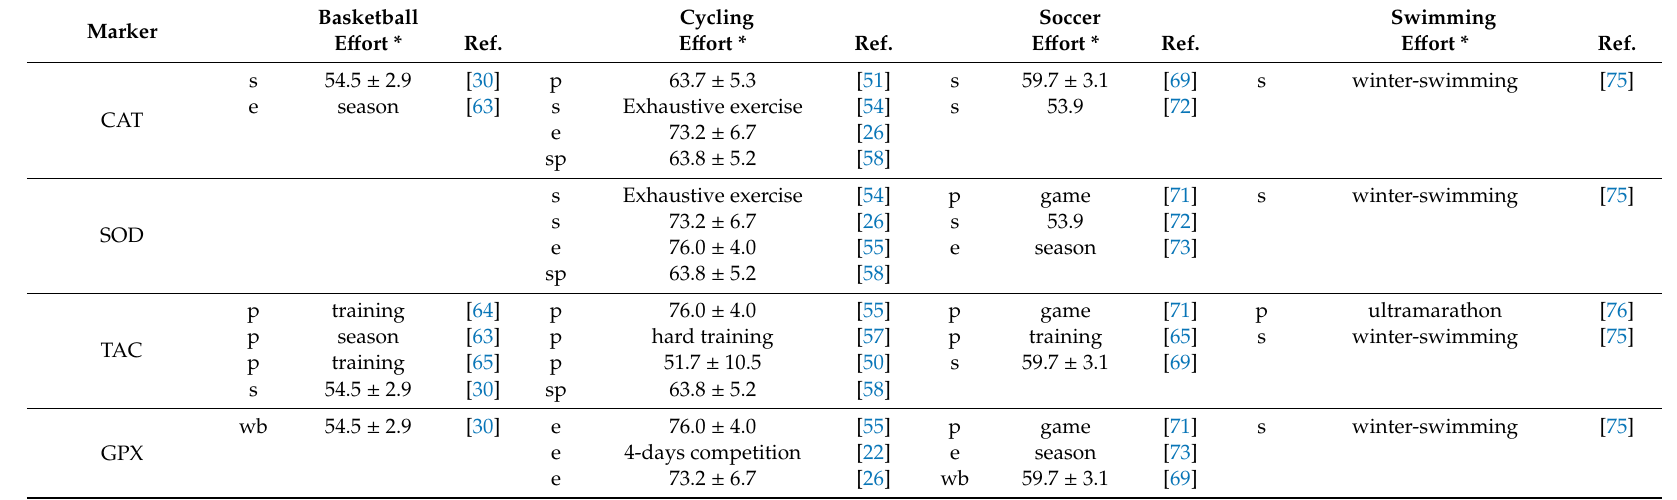
Table 2. Oxidative stress marker measured in cycling, basketball, soccer and